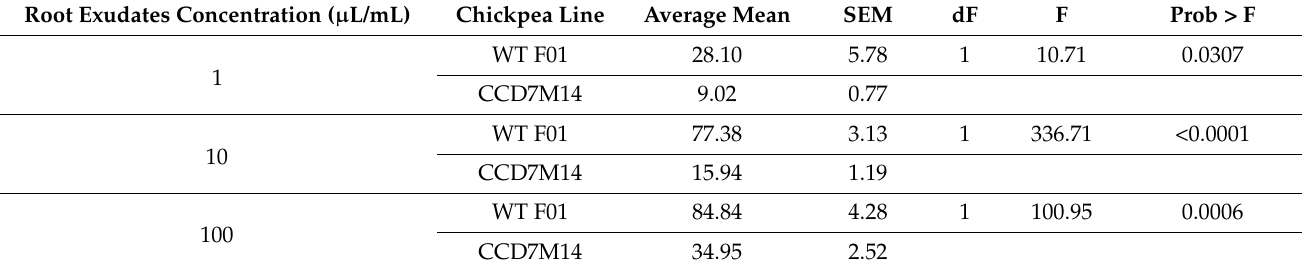
Table 3. Statistical analysis of the broomrape seed germination caused by root exudates. The results were subjected to ANOVA. The experiments were conducted with five replications. SEM—standard error of the mean, dF—Degrees of Freedom; F—F ratio, Prob > F—F